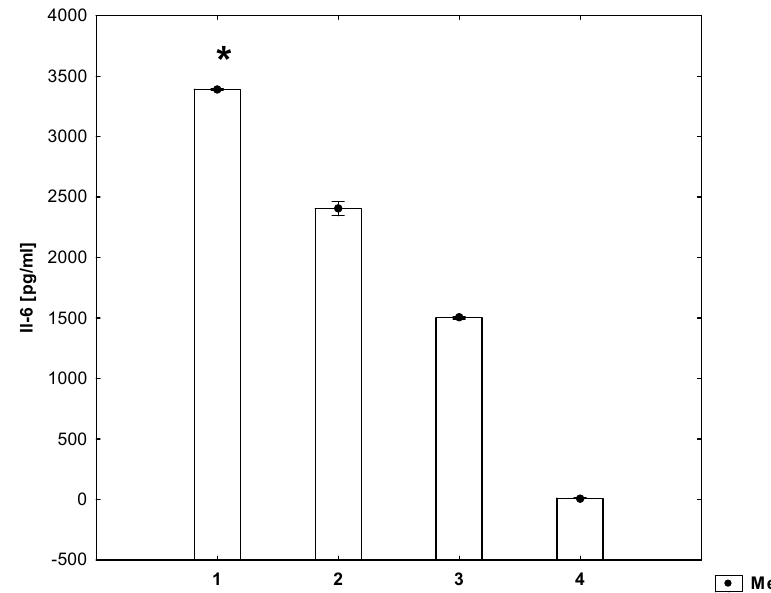
Figure 2. Concentrations of Il-6 in the cell culture supernatant (ANOVA). 1—cell suspension + mitogen + homocysteine, 2—cell suspension + mitogen, 3—cell suspension, 4—medium. * statistically significant difference compared to every other group for p ≤ 0.05.